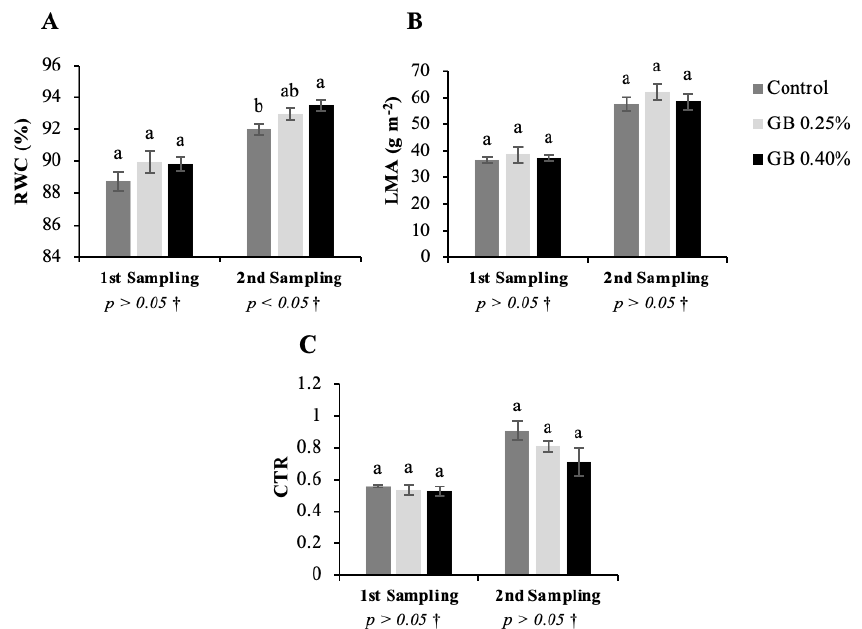
Figure 1. Represents leaf water status in sweet cherry tree leaves. Relative water content (RWC ( A ), leaf mass per ares (LMA) ( B ), and cuticular transpiration rate (CTR) ( C ), for the cv. Lapins leaves subjected to the different treatments. † Indicates that the p values were calculated from the one-way ANOVA analysis after verifying the assumptions of normality and homogeneity of variances. When a significant effect was observed ( p < 0.05), Tukey’s post-hoc test was applied. Regarding relative water content (RWC) results (Figure 1A), unlike the first sampling of leaves, the second sampling revealed significant differences among treatments ( p < 0.05). In the first sampling, RWC ranged between 88.73% and 89.97%. There was an increase in RWC in the second sampling for all treatments. GB 0.40%, GB 0.25%, and control treatment led to RWC values of 93.50, 92.97, and 91.99%, respectively. Results show higher RWC in leaves of trees treated with GB; however, it was the GB 0.40% treatment that induced better water